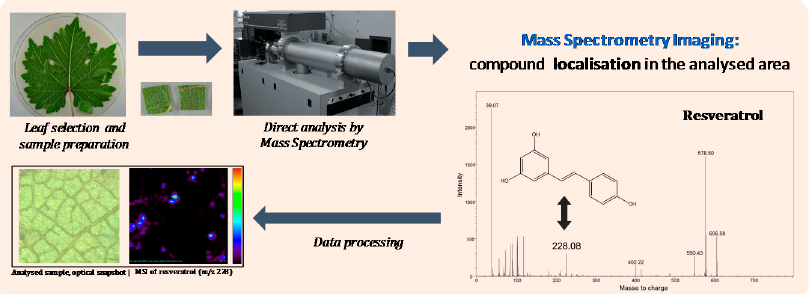
Figure 2. General scheme of Imaging Mass Spectrometry by (MA)LDI-TOFMS. The sample, here an infected vine leaf (with Plasmopara viticola ), is cut and fixed to the MALDI plate with or without matrix deposition. The MALDI plate is introduced in the mass spectrometer. A grid pattern covering the surface to be analyzed is defined. The sample is then mapped; each pixel of the grid is composed of mass spectra. Thank to data processing software, the image of the distribution of each ion of interest can be build (here m/z 228 for resveratrol). The image can be compared with control sample or superposed to the initial